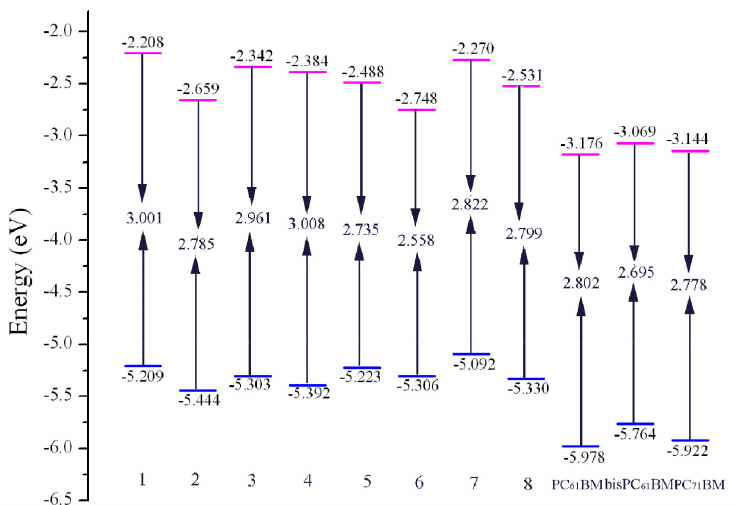
Figure 2. Evaluation of calculated FMO energies for investigated molecules as well as FMO energies for PC 61 BM, bisPC 61 BM, and PC 71 BM at the PBE0 / 6-31G (d,p)